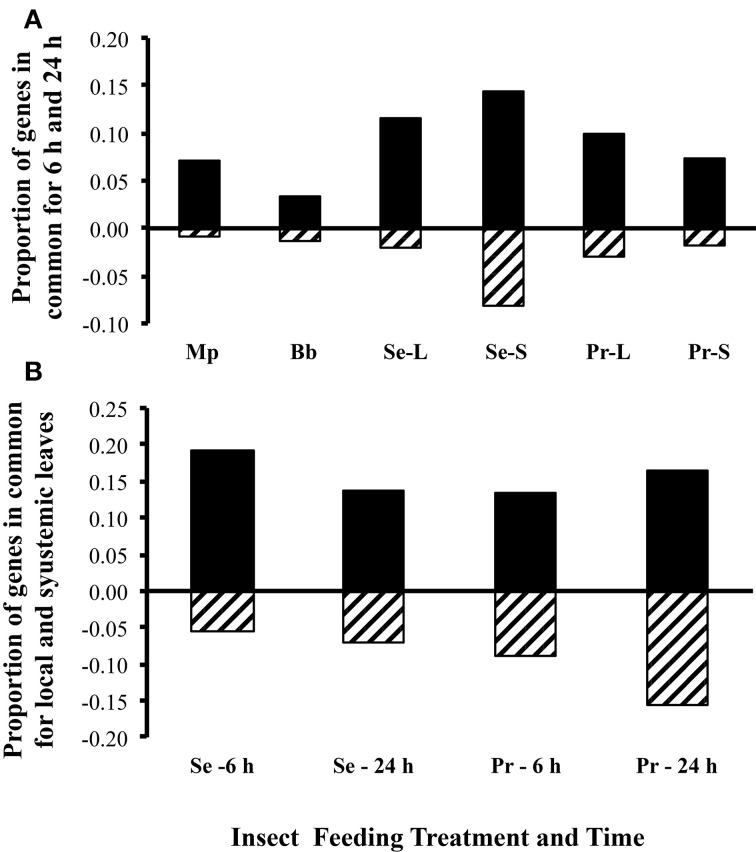
Proportion of A. thaliana genes differentially expressed at both time points and leaf types. (A) Proportion of genes differentially expressed at both time points, by treatment. (B) Proportion of genes differentially expressed in both leaf types, by treatment and time. Black bars, upregulated genes; cross hatched bars, downregulated genes; Mp, Myzus persicae; Bb, Brevicoryne brassicae; Se, Spodoptera exigua; Pr, Pieris rapae; L, local damaged leaves; S, systemic undamaged leaves (local and systemic leaves were from the same plant).